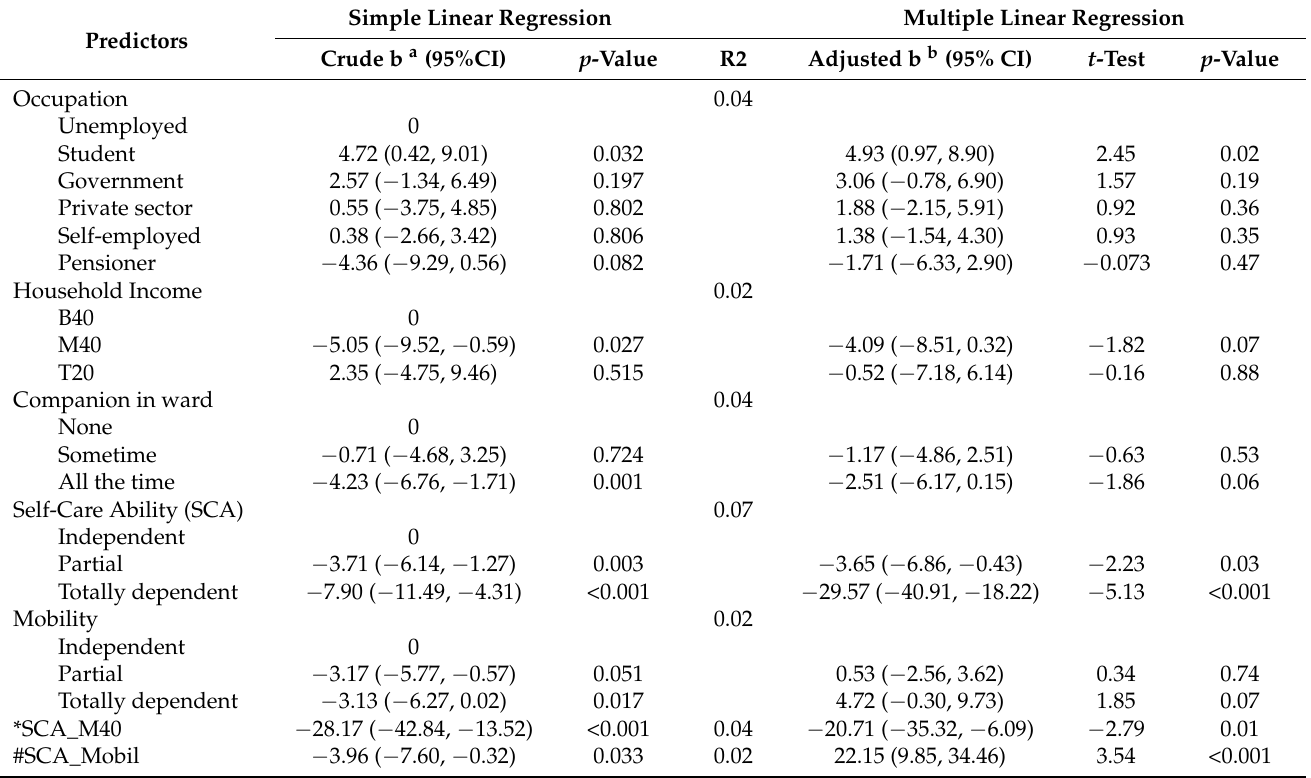
Table 6. Predictors of compassionate care score perceived by patients ( n =